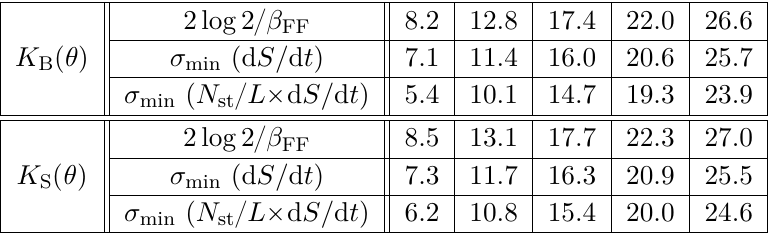
Table 3 . σ min for the quench with K B p θ q and K S p θ q